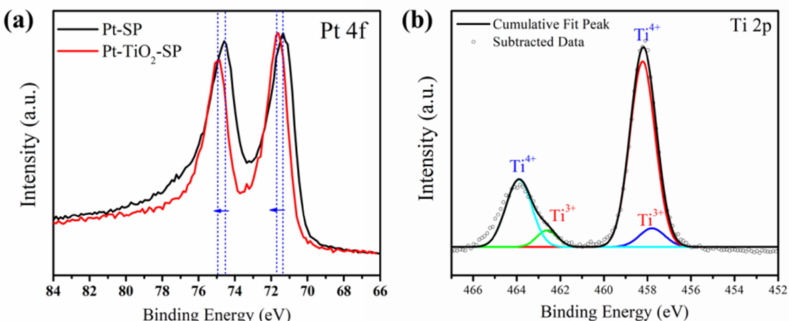
Figure 5. ( a ) XPS Pt 4f spectra of Pt-SP and Pt-TiO 2 -SP catalysts, and ( b ) Ti 2p spectrum of Pt-TiO 2